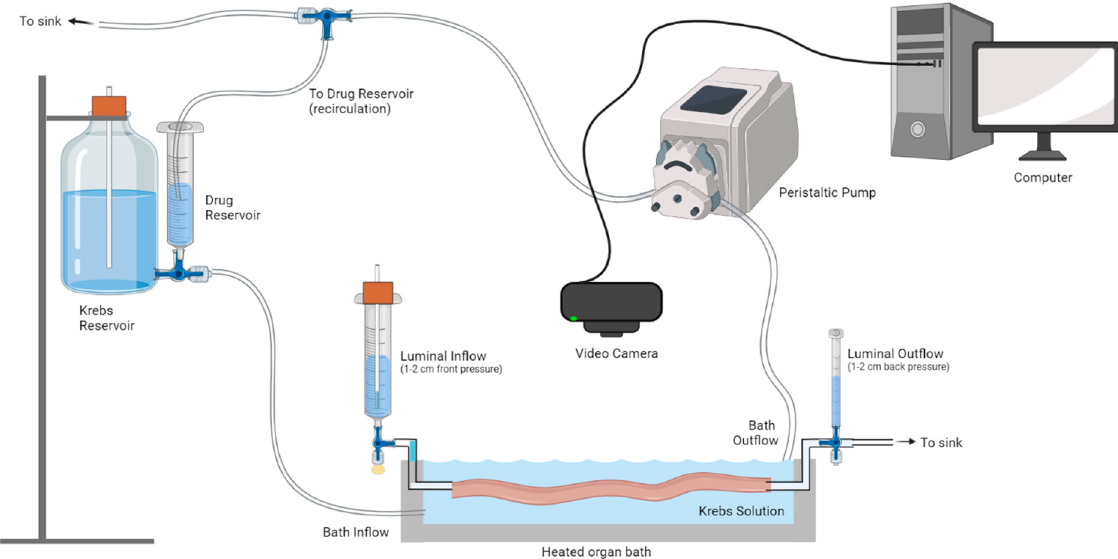
Figure 1. Video imaging analysis of ex vivo colonic motility. An isolated colon was placed in a heated organ bath and cannulated at the oral and anal ends. Luminal inflow was maintained at constant pressure, and fresh Krebs solution perfused the organ bath. A peristaltic pump was used to maintain a constant amount of Krebs in the organ bath. To conserve the number of antagonists used, they were recirculated from the reservoir via a peristaltic pump. Video recordings of colonic contractions were captured using a video camera connected to a computer. Four lots of 15 min recordings were made at each time point: (i) initial Krebs, (ii) antagonist (or time control Krebs), and (iii) washout. Figure made using Biorender.